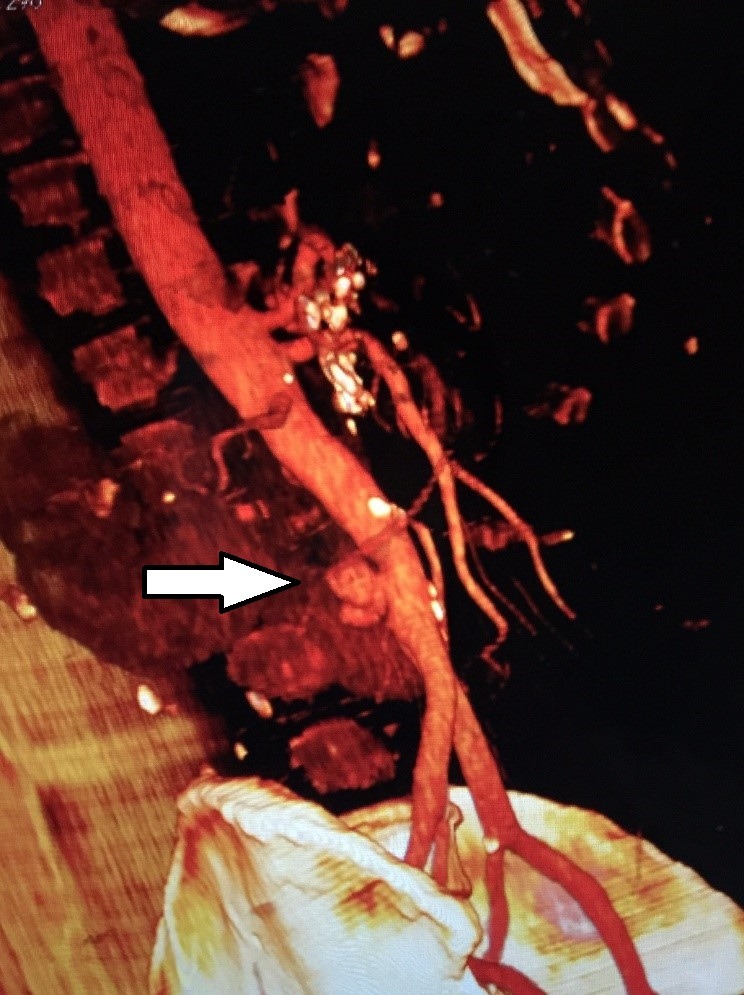
Angiotomography of the abdominal aorta, showing a pseudoaneurysm of the posterior wall.